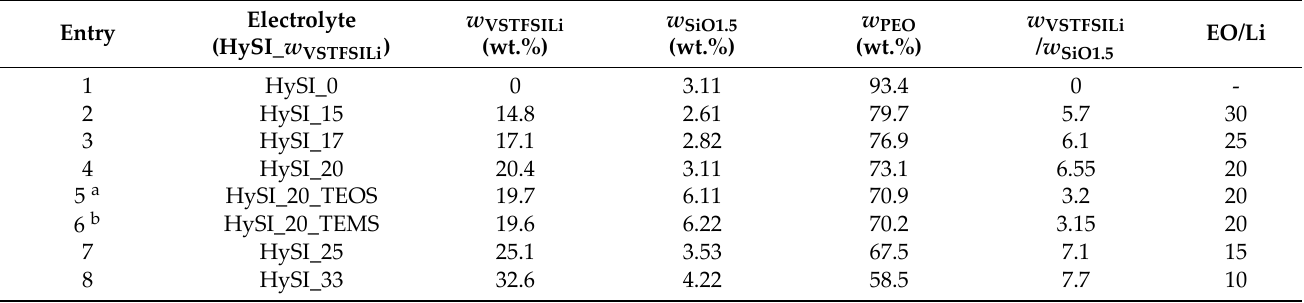
Table 2. Composition of the HySI